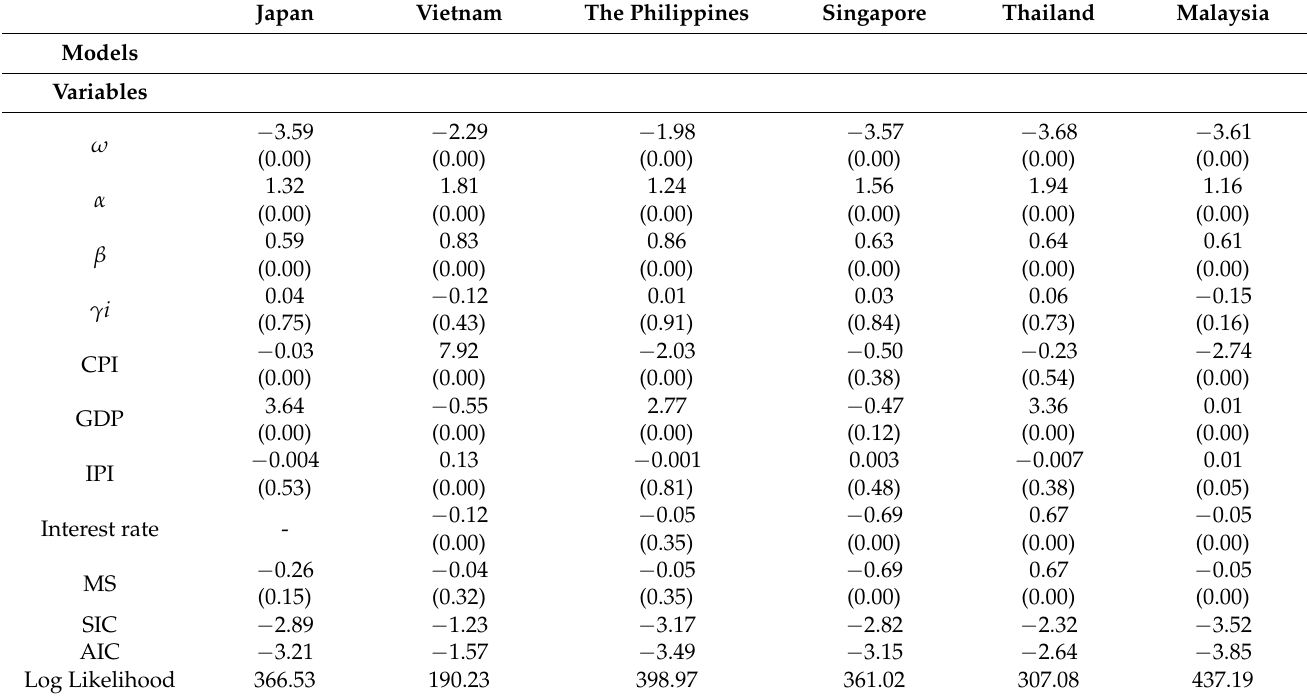
Table 5. EGARCH Analysis of Dynamics of Volatility for pan-Asian Countries over the Period of January 2000 to December 2019. Japan Vietnam The Philippines Singapore Thailand Malaysia Models